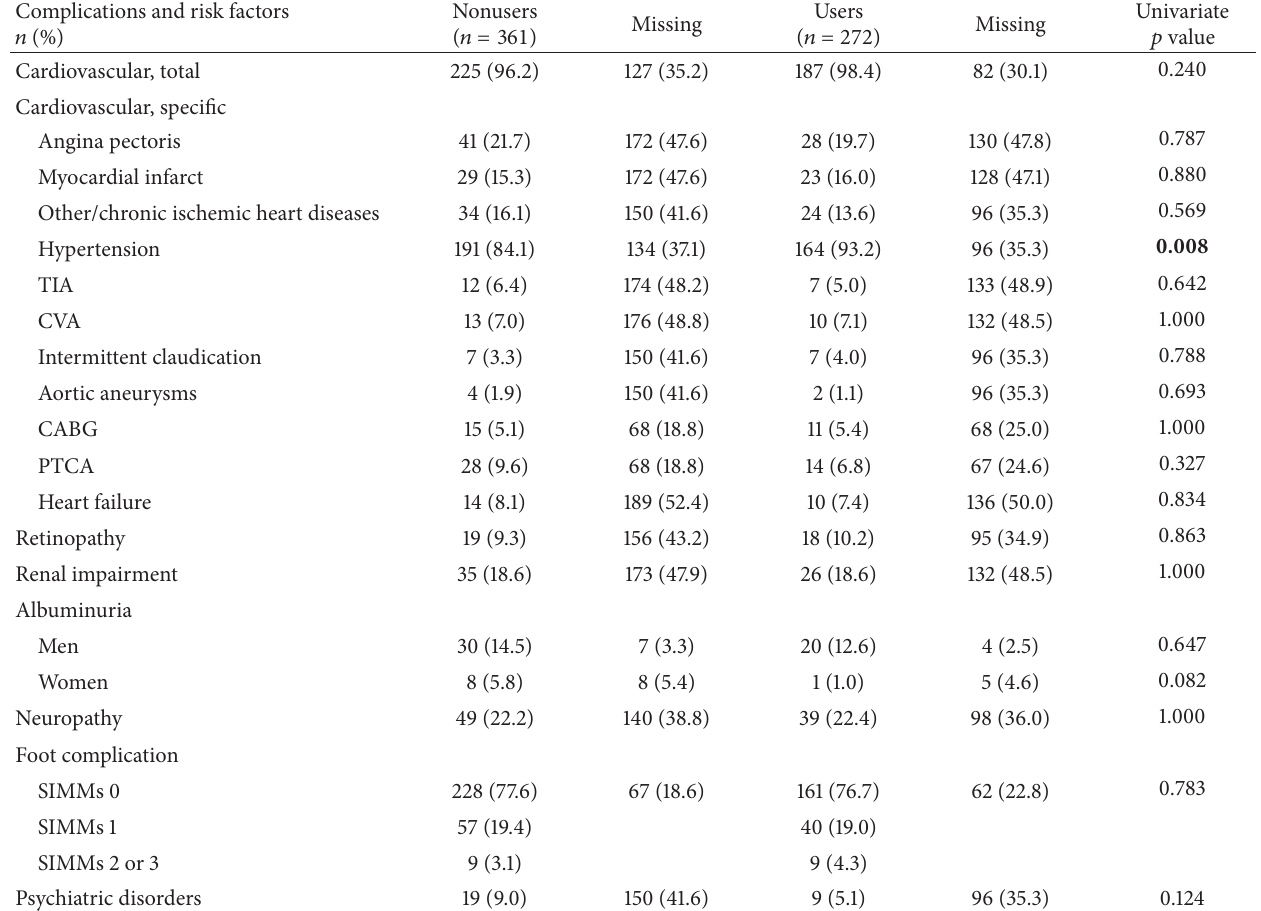
Table 6: Complications and risk factors of users and